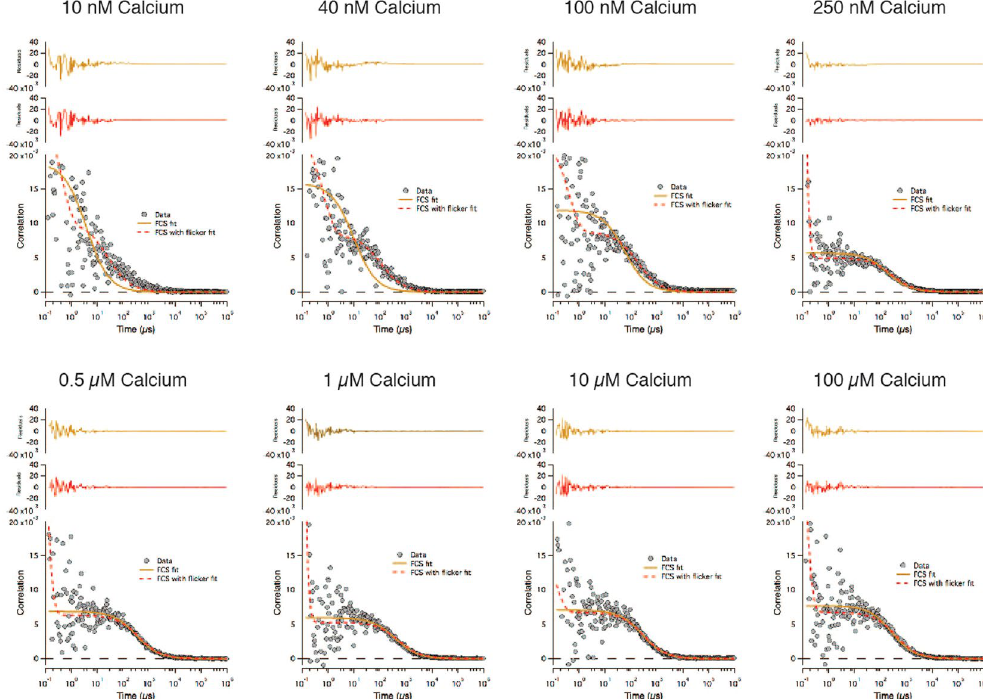
Figure 9. Auto-FPFA cross-correlation analysis of GCaMP6s as a function of free-calcium concentration. The FCS component of auto-FPFA was used to measure cross-correlation data of homogenates prepared from cells expressing GCaMP6s. Representative cross-correlation curves are plotted at different calcium concentrations. Homogenates used at 10, 40, 100 and 250 nM calcium was six times as concentrated as those used at 0.5, 1, 10, and 100 µ M calcium. Each auto-FPFA cross-correlation curve was fit to either a simple single diffusion component FCS model (FCS fit, solid yellow traces) or a more complex FCS model that allows for the diffusion of a single fluorophore that can ‘flicker’, i.e. transition between a dark and bright state (FCS with flicker fit, dashed red traces). Residuals for each fit are plotted. Note that at low calcium concentrations the simple FCS fit model fails to fit the data